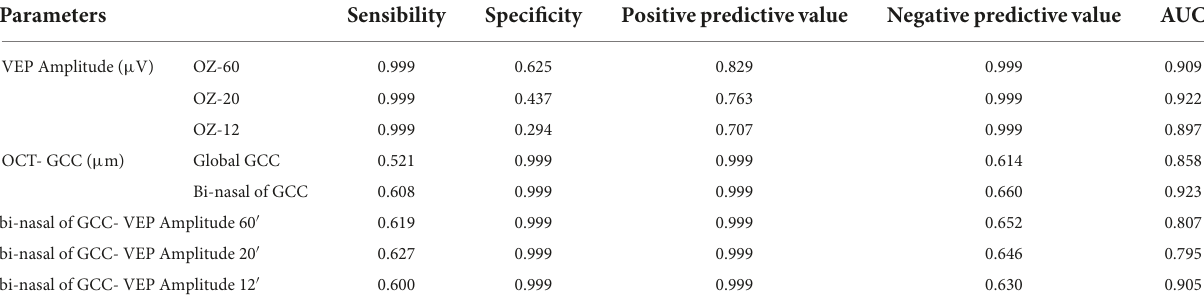
TABLE 2 Diagnostic value of proposed parameters.